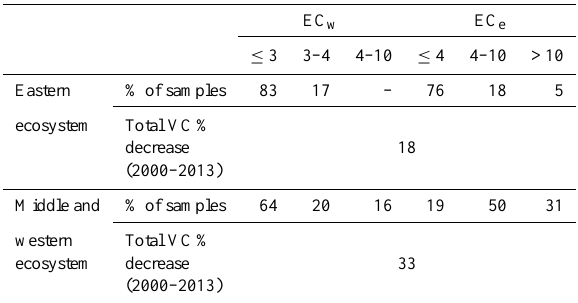
Table 2. Water and soil-deteriorated parameter (salinity) in relation to total VC area.